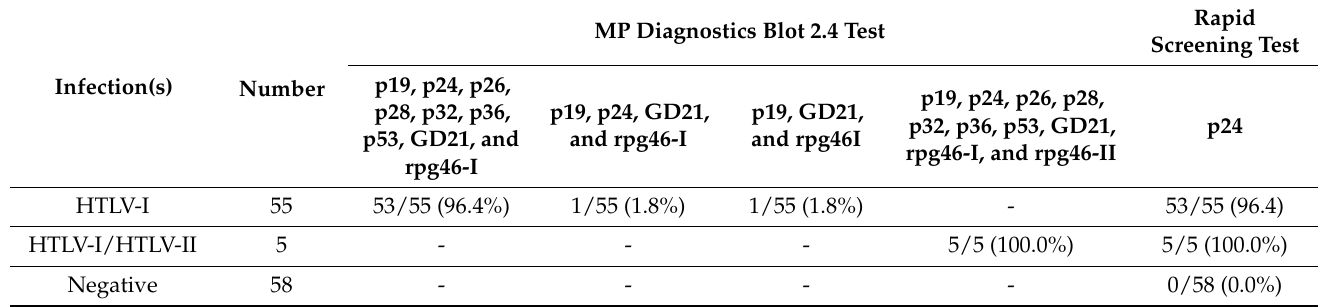
Table 1. MP Diagnostics Blot 2.4 Test and Rapid Screening Test for HTLV-I test results from serum specimens collected in Salvador, Bahia, Brazil.